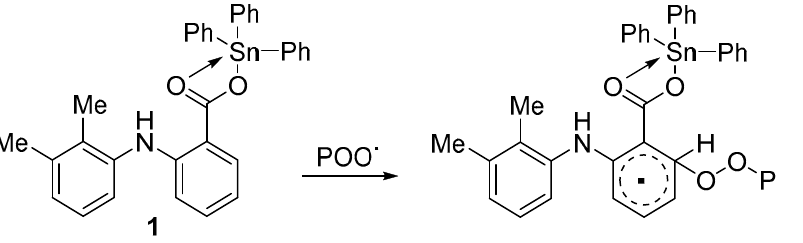
Figure 10. Organotin 1 as a radical scavenger.